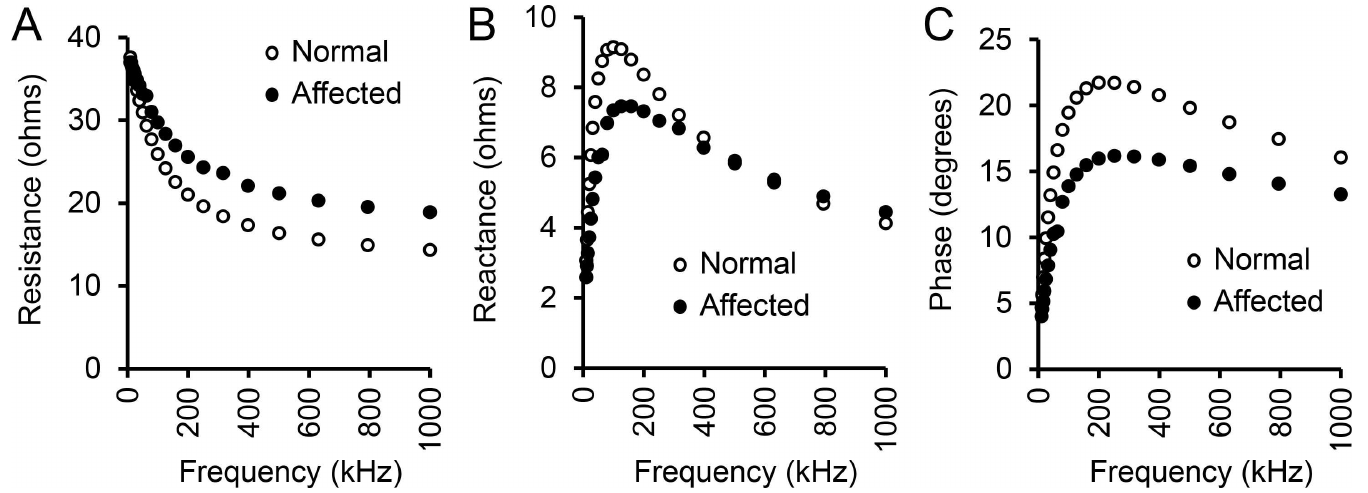
Fig 3. Multifrequency EIM signature in normal and affected dogs. (A) Relationship betweenresistanceand frequency. (B) Relationship between reactanceand frequency. (C) Relationship betweenphase and frequency. Open circle, normal dogs (n = 10); Closedcircle, affected dogs (n = 14). Points represent averagevalues across the populationstudied.